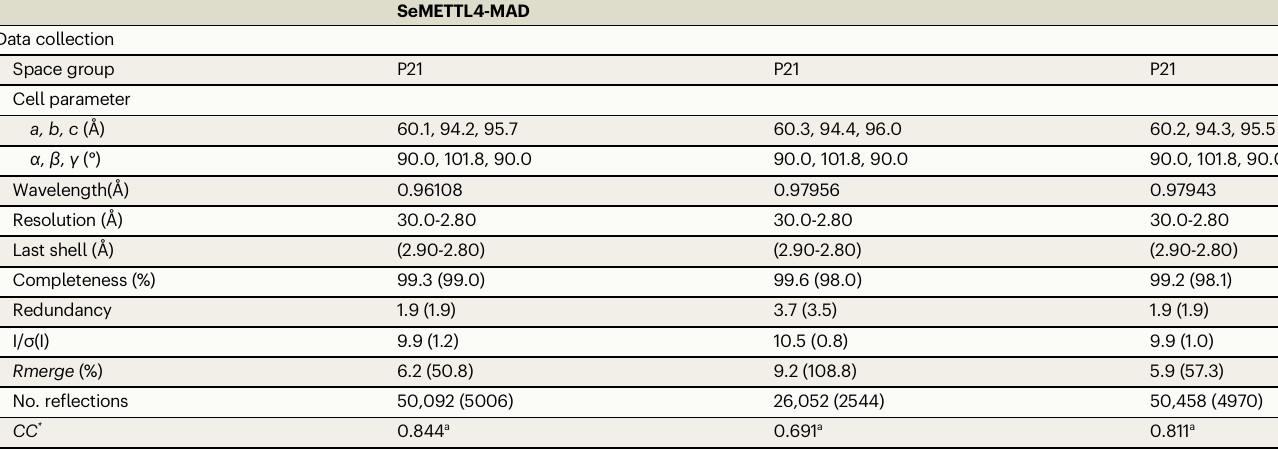
Table 1 | The data collection of SeMETTL4 for structure determination SeMETTL4-MAD